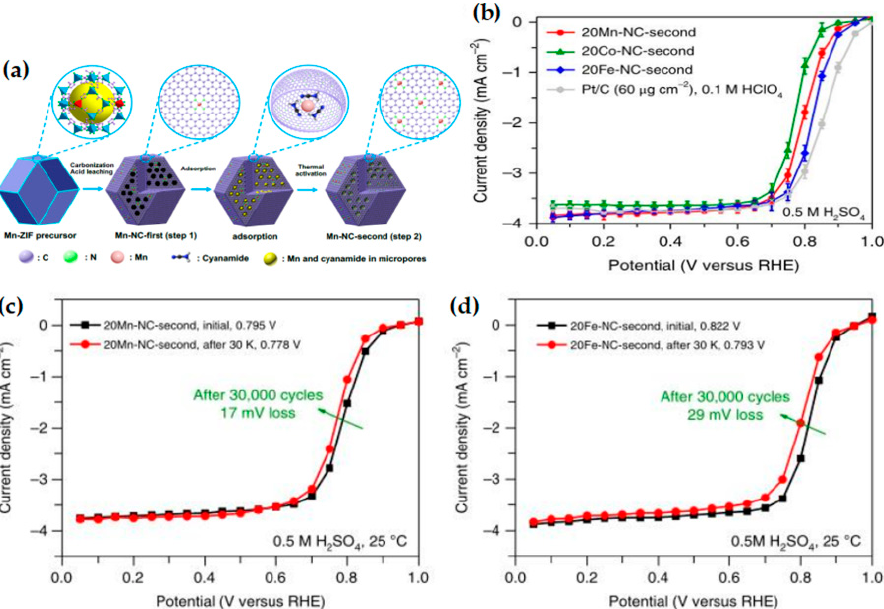
Figure 8. ( a ) Schematic of atomically dispersed Mn-N 4 site catalyst synthesis; ( b ) comparison of catalytic activity of Fe-, Co- and Mn-N-C catalysts prepared from identical procedures, and steady-state ORR polarization plots before and after potential cycling stability tests for the 20 Mn-NC-second ( c ) and 20Fe-NC-second ( d ) catalysts. Copyright 2018, Nature Catalysis [91]. Compared with Fe-N 4 , Co-N 4 , and Mn-N 4 , the Cu-N 4 coordination configuration has